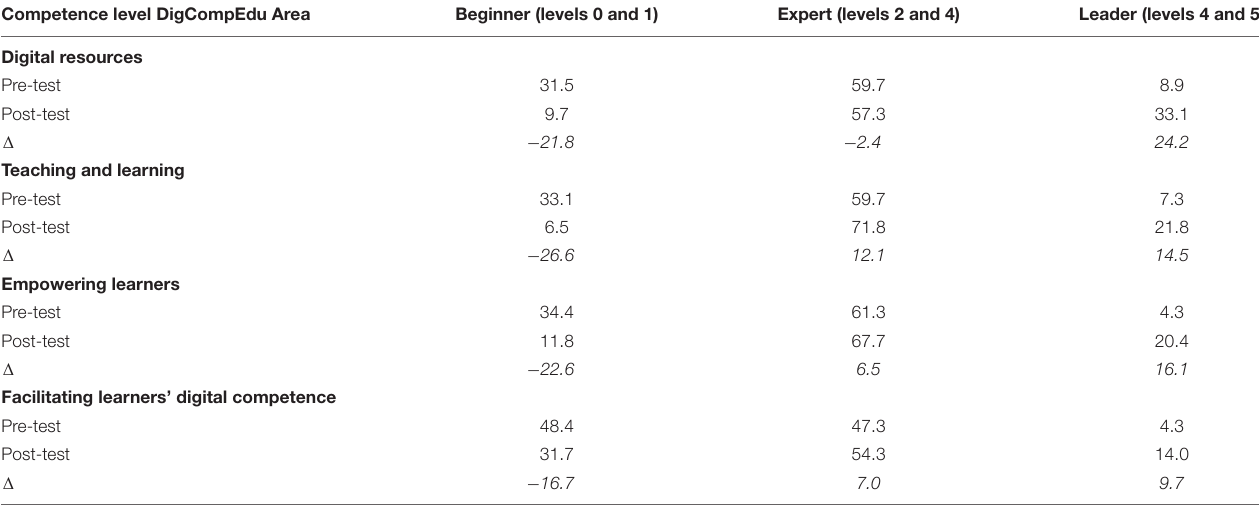
TABLE 1 | The level of Case 1 participants’ digital competences, by percentage.